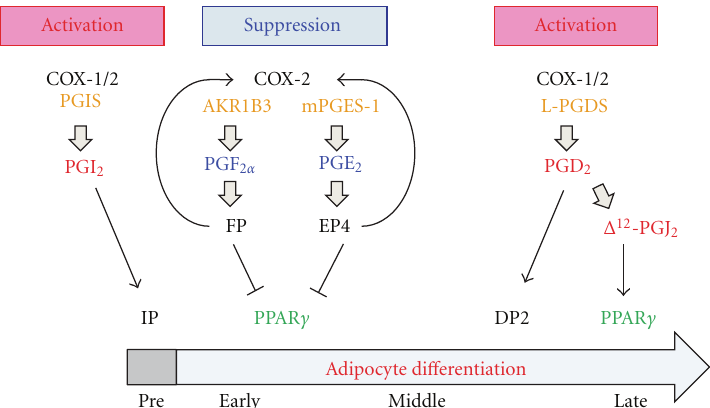
Figure 2: Regulation of adipogenesis by prostaglandins. “Pre ” indicates adipocyte precursor cells. “Early , ” “ Middle , ” and “ Late” mean early, middle, and late phases of adipogenesis,